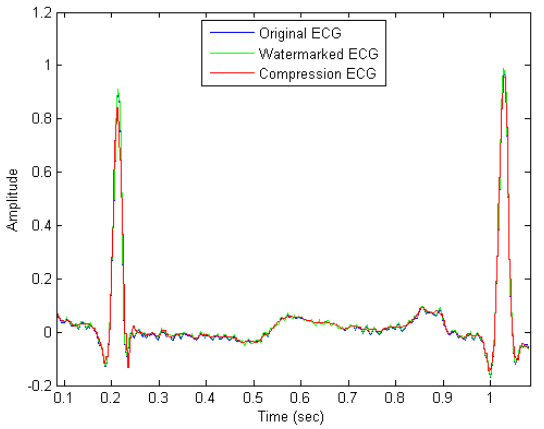
Figure 8. The original, watermarked, and compression ECG signal; the blue curve indicates the original, the green curve represents the watermarked, and the red curve represents the